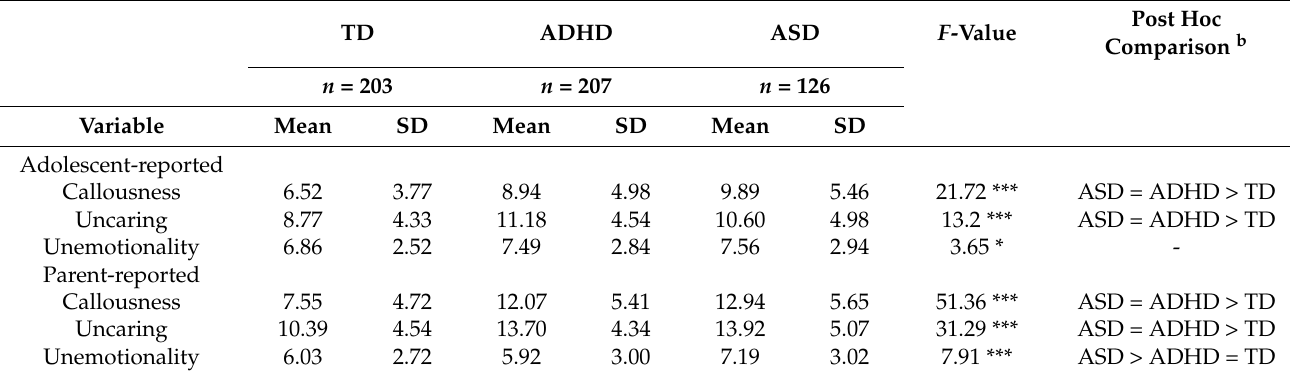
Post Hoc Comparison b n = 126